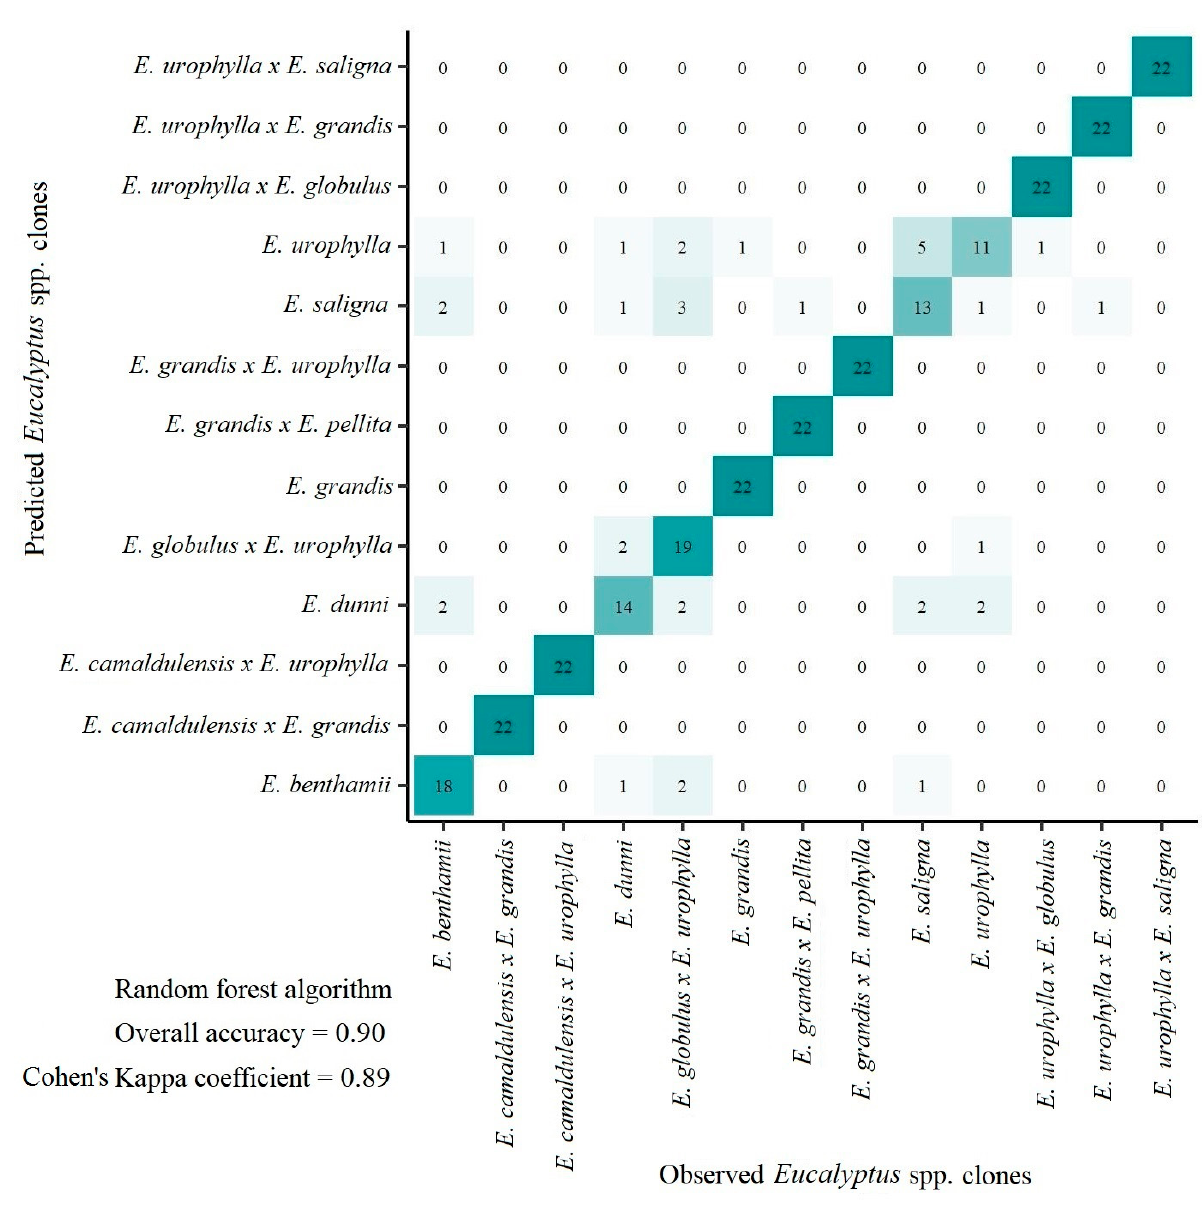
Figure 4. Confusion matrix of Eucalyptus spp. clone prediction models based on portable X-ray fluorescence (pXRF) elemental data. Darker colors indicate higher number of samples in that class.